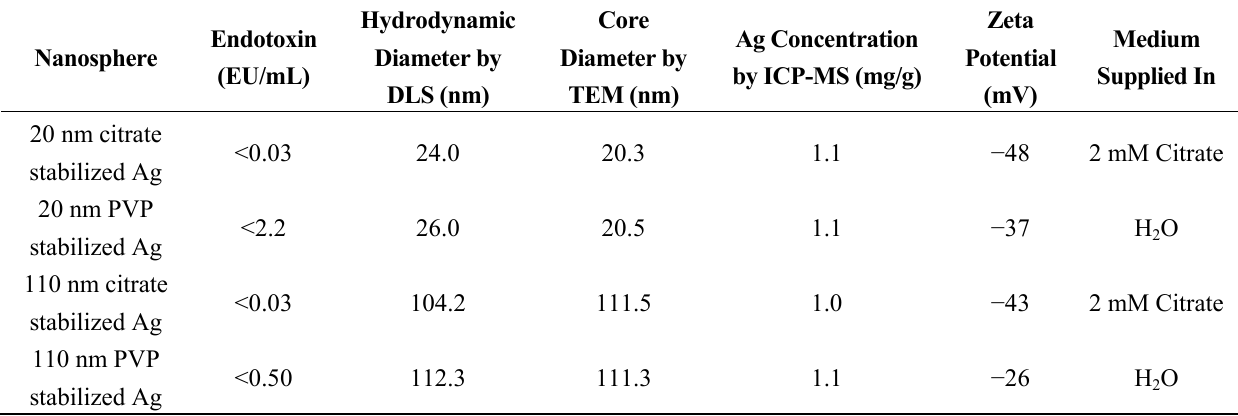
Table 2. Physical characterization of stabilized Ag nanospheres used in this study. All information provided by Nanotechnology Characterization Laboratory